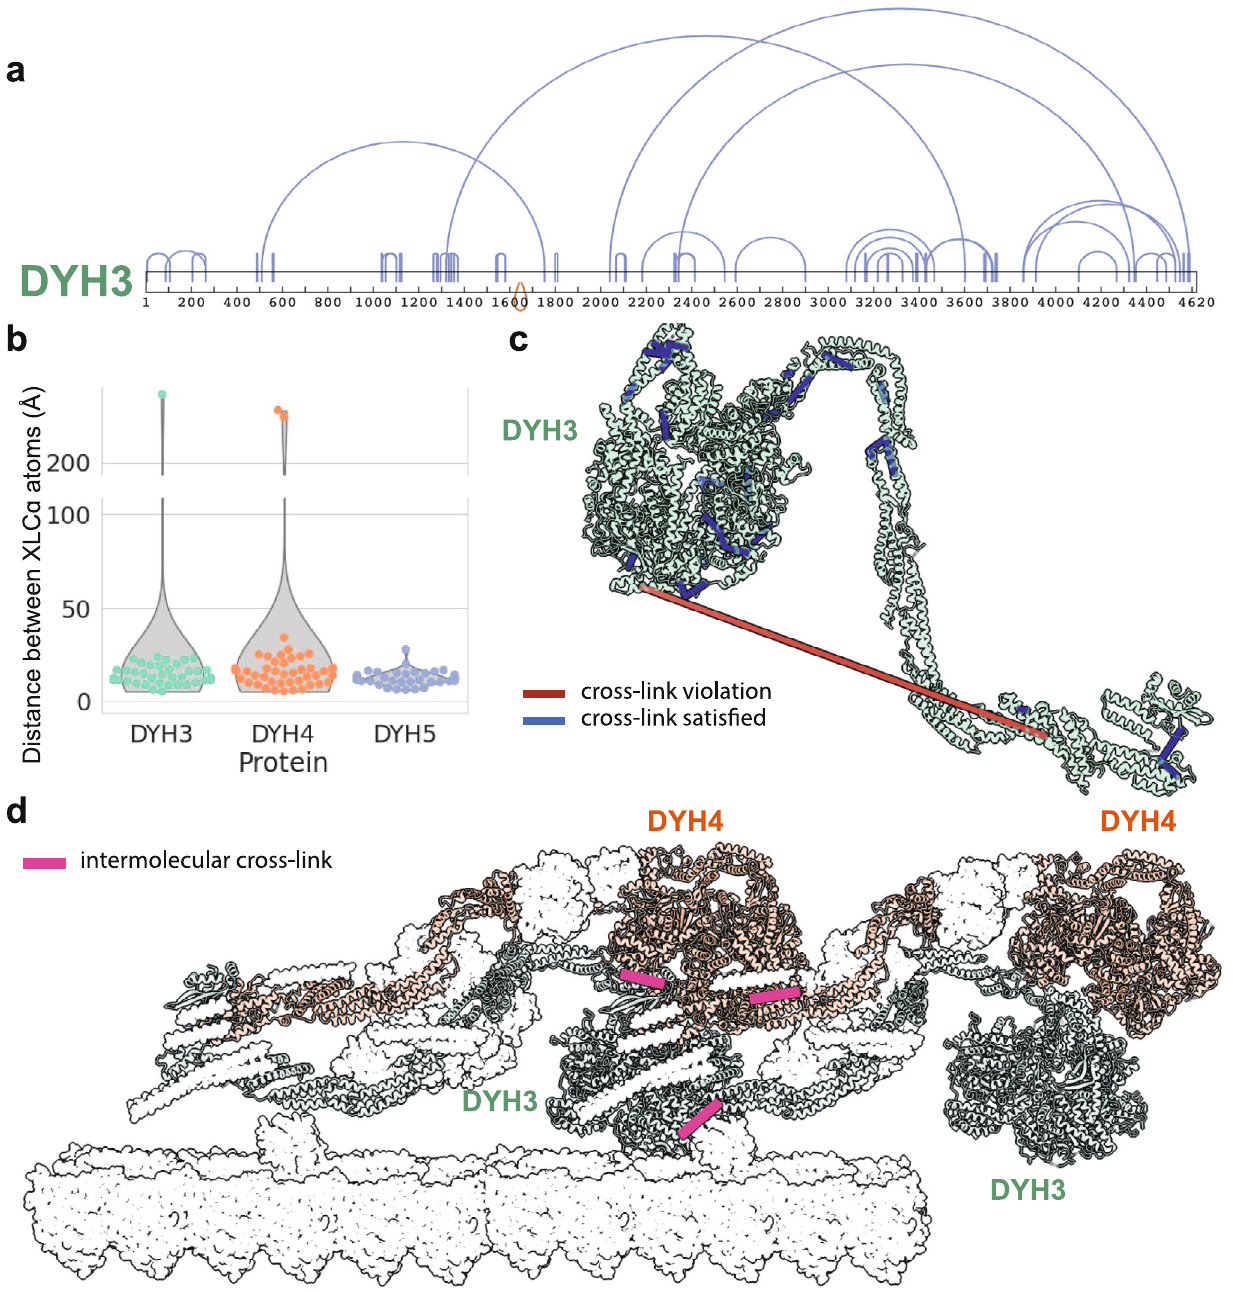
Fig. 2 In situ cross-links agree with the known T. thermophila outer dynein arm cryo-EM structure. a Cross-link diagram for DYH3 shows the abundance of intramolecular cross-links within the protein. b We observed a total of 155 intramolecular cross-links across all three dynein heavy chain proteins, 124 of which corresponded to structured regions and hence could be used as a validation set. Intramolecular distances are plotted for these 124 cross-links. c Intramolecular cross-links mapped onto the DYH3 structure. In summary, there was a 97% agreement between cross-links and cryo-EM structures of the dynein proteins. d In situ assembly of ODAs, show that perceived monomer cross-link violations are actually satis fi ed between copies of dynein proteins, improving the cross-link agreement to 99% (PDB ID:7MOQ) (see also Supplementary Table S1 for speci fi c